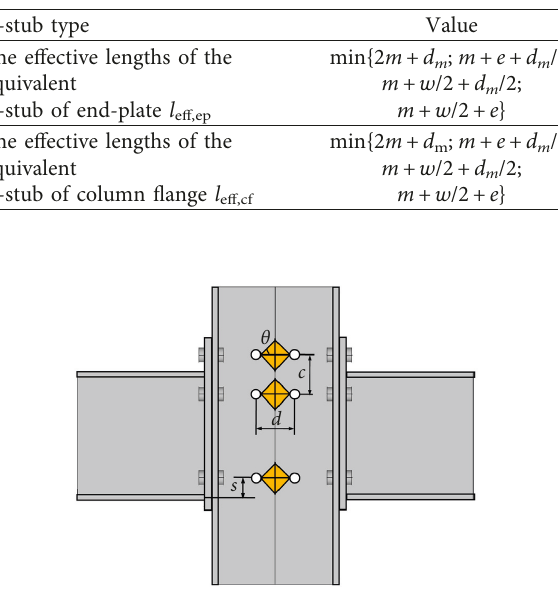
Figure 13: An illustration of the calculation of ignored parts of the column